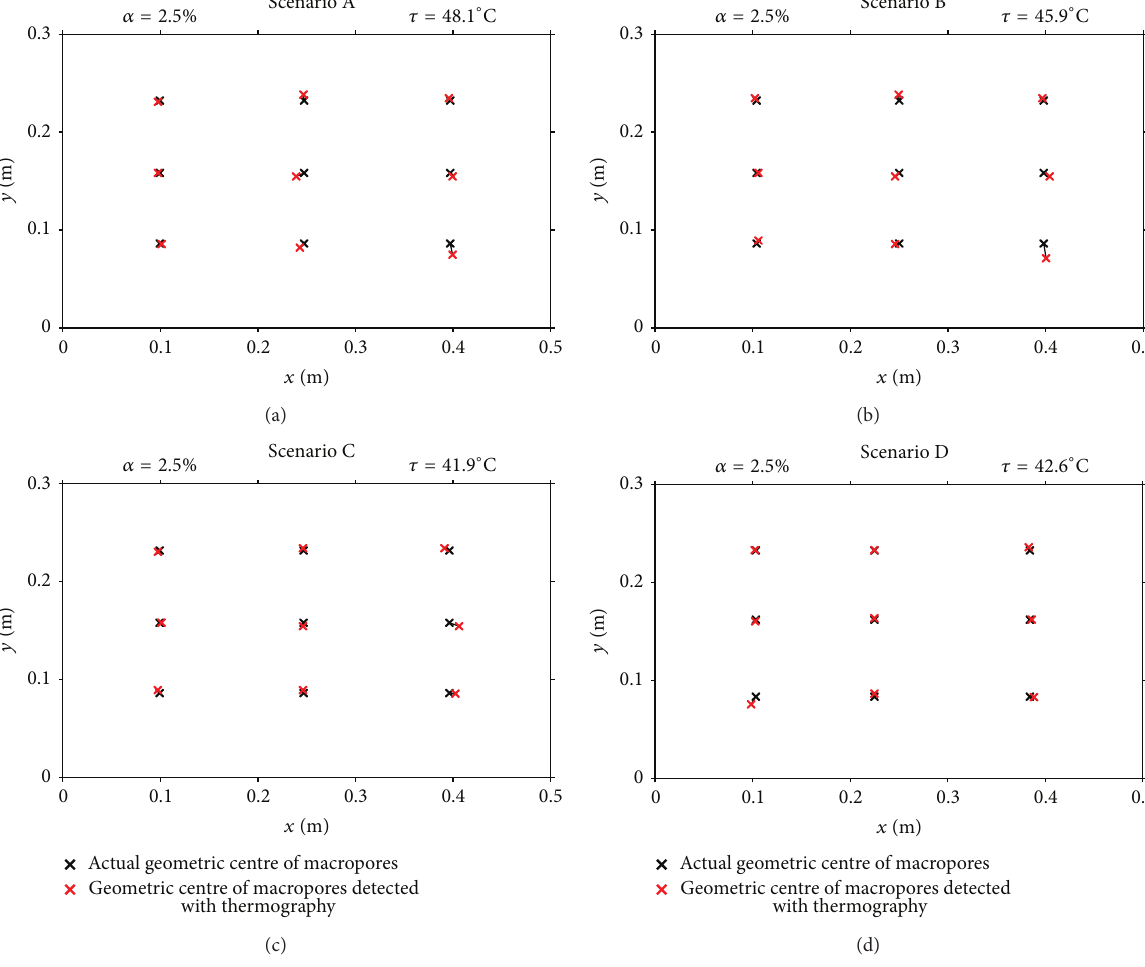
Figure 6: Comparison between the actual geometric centre of the macropores and their geometric centre detected using thermography, for the four scenarios. See Figure